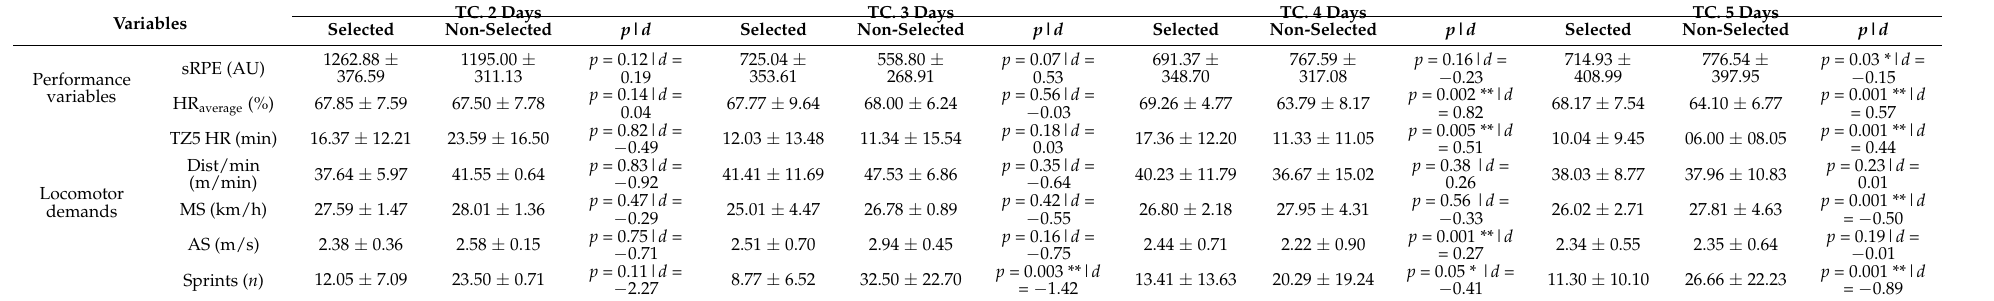
Table 3. Performance variables (sRPE, HR average , VO2 max , and TZ5 HR) and locomotor demands (dis/min, maximal speed, average speed, and sprint number)